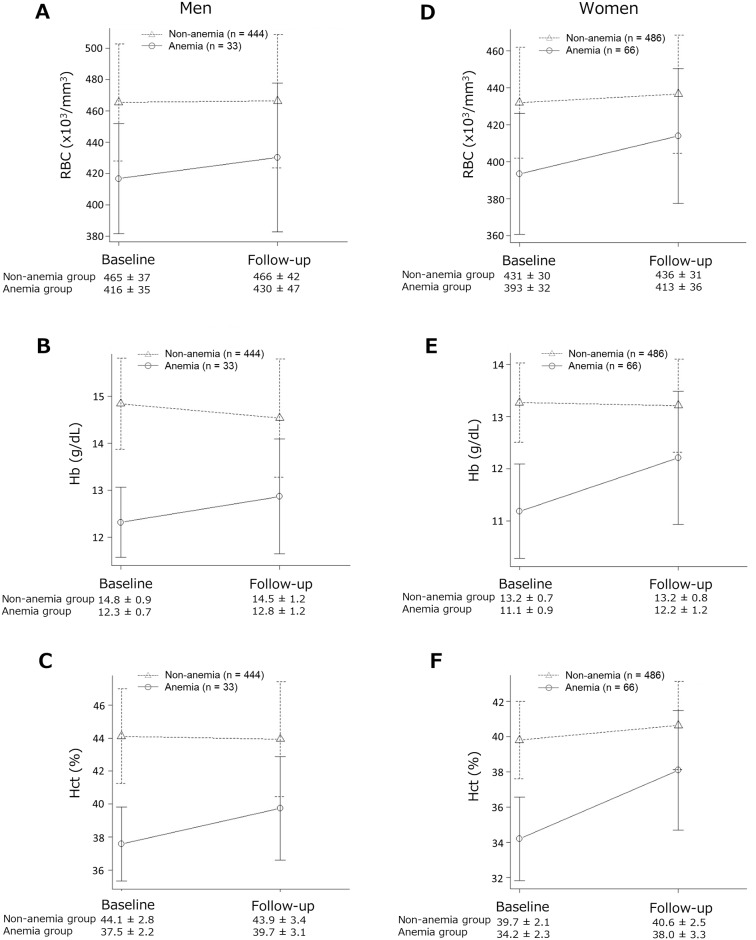
Differences in erythroid parameters stratified according to hemoglobin (Hb) levels at baseline.In men without anemia, Hb [Fig 1.B] and hematocrit (Hct) [Fig 1.C] levels were lower at follow-up than at baseline, whereas red blood cells (RBC) counts [Fig 1.A] were unchanged. In women without anemia, RBC counts [Fig 1.D] and Hct levels [Fig 1.F] were higher at follow-up than at baseline, whereas Hb levels [Fig 1.E] were unchanged. In both men and women with anemia, all three parameters were higher at follow-up.